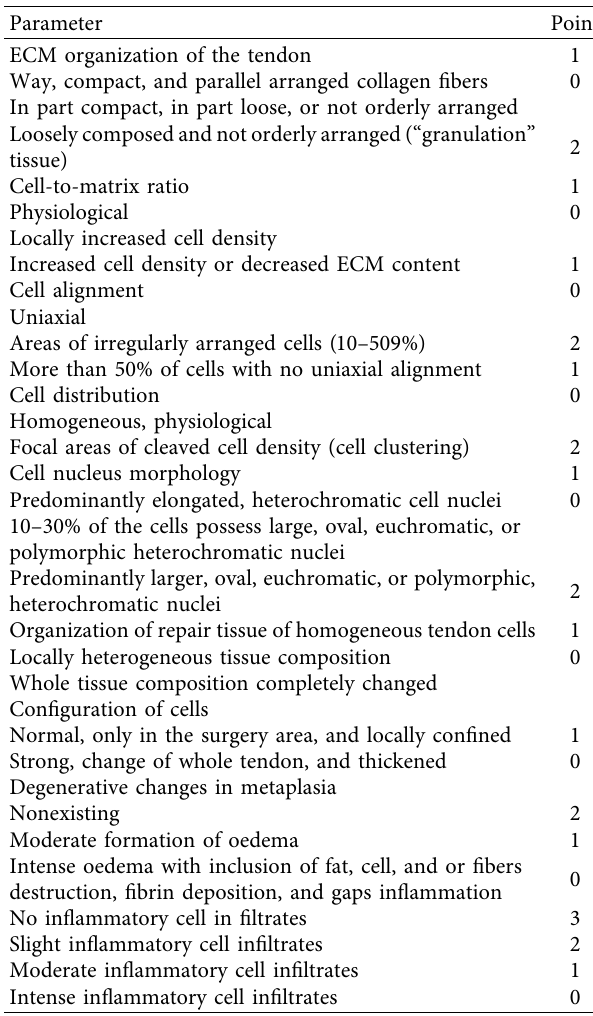
Table 2: Morphological scoring system. Table 3: Organizational scoring